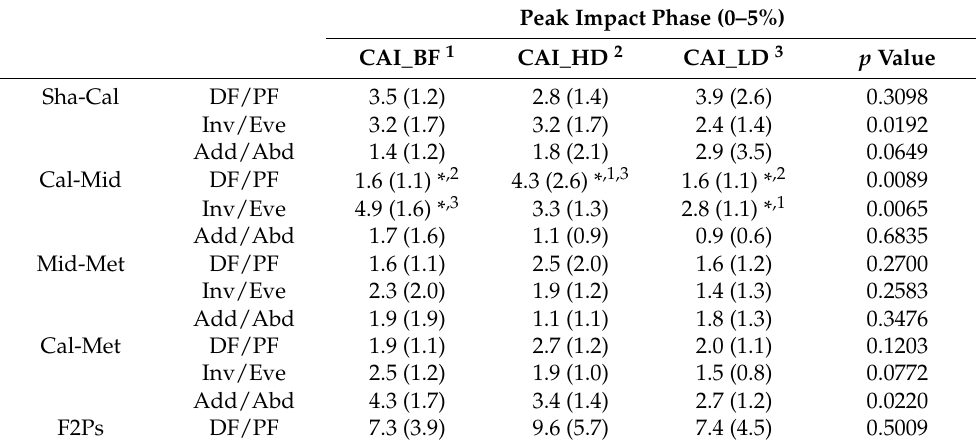
Table 3. Summary of mean RoM and standard deviation (in degrees) during peak impact phase in